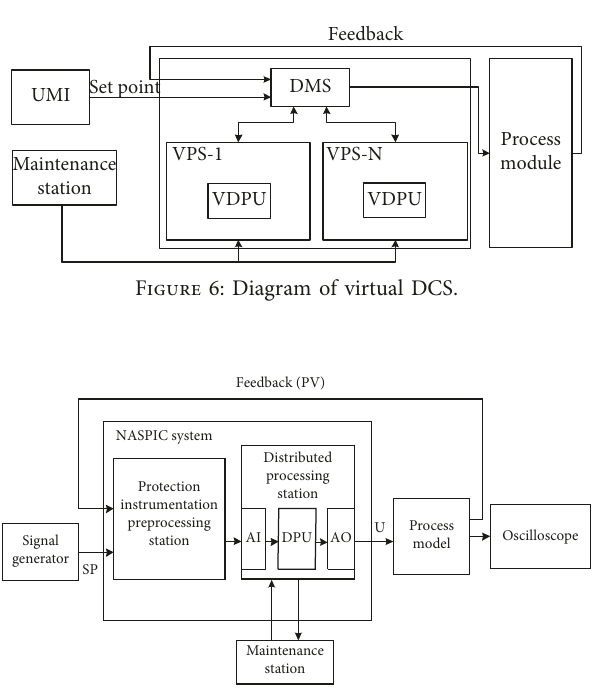
Figure 7: Diagram of physical test